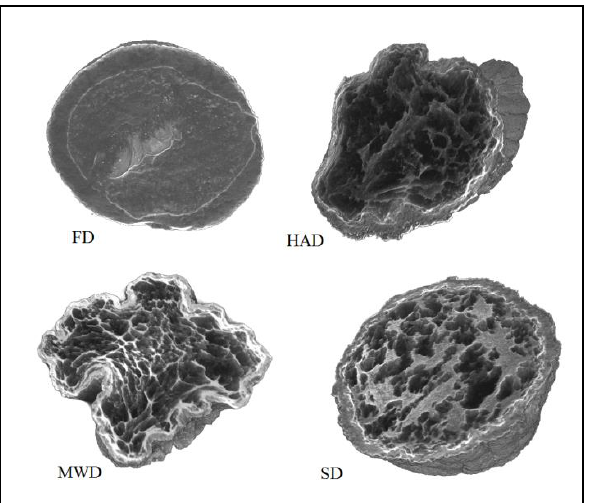
Figure 2. X-ray microtomography images of mushroom samples after drying. FD—freeze drying; HAD—hot air drying; MWD—microwave drying; SD—sun drying.